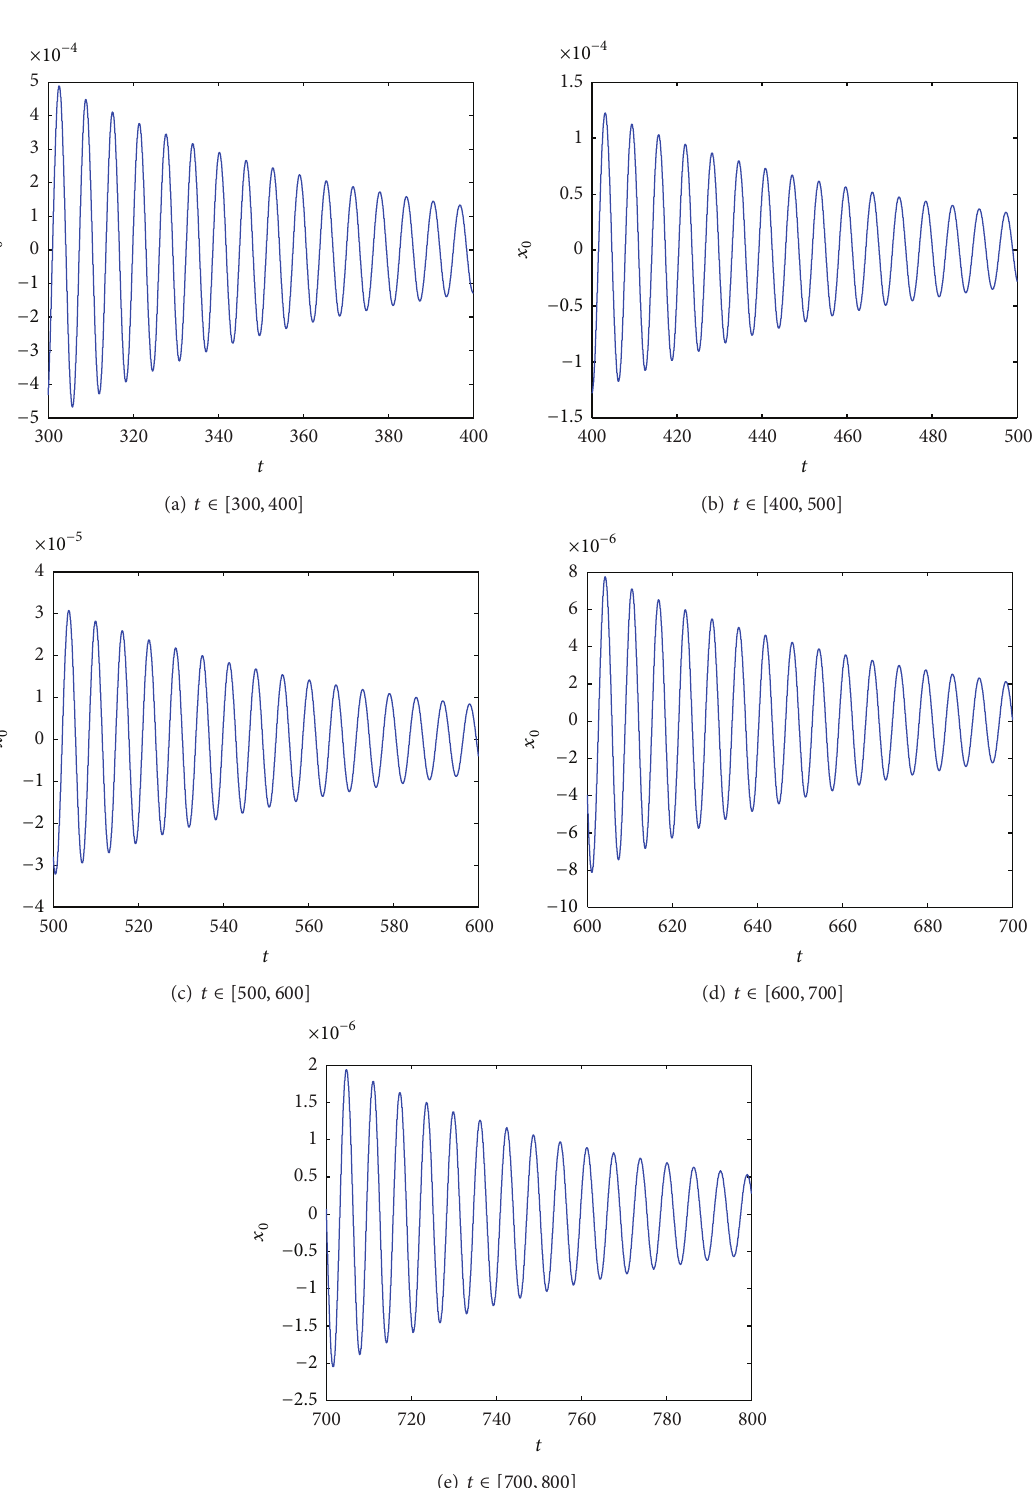
Figure 6: The time trajectories of EMR 𝑥 0 for different time